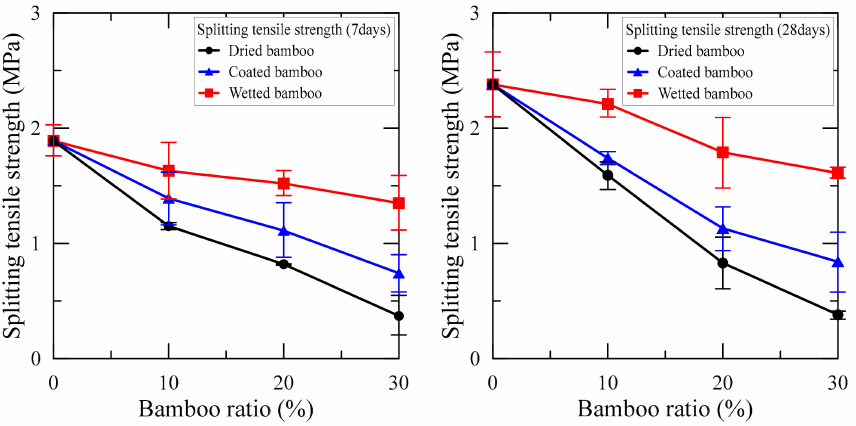
Figure 8. Results of splitting tensile strength